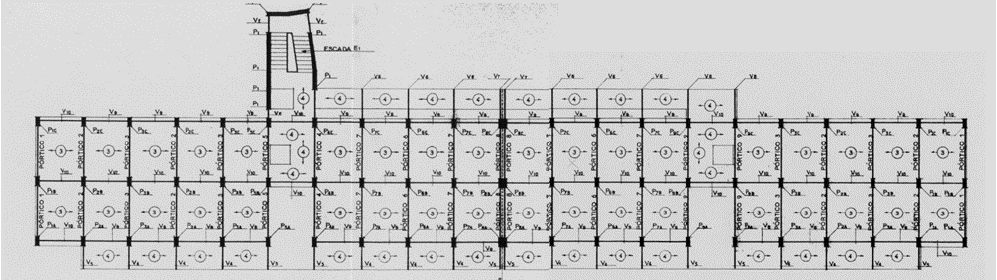
Figure 5. Structure plan of the apartments.